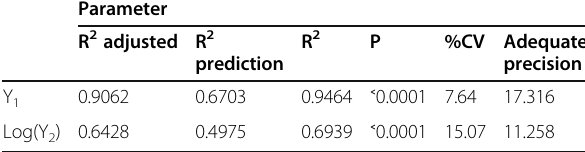
Table 3 Determination of accuracy and precision Parameter